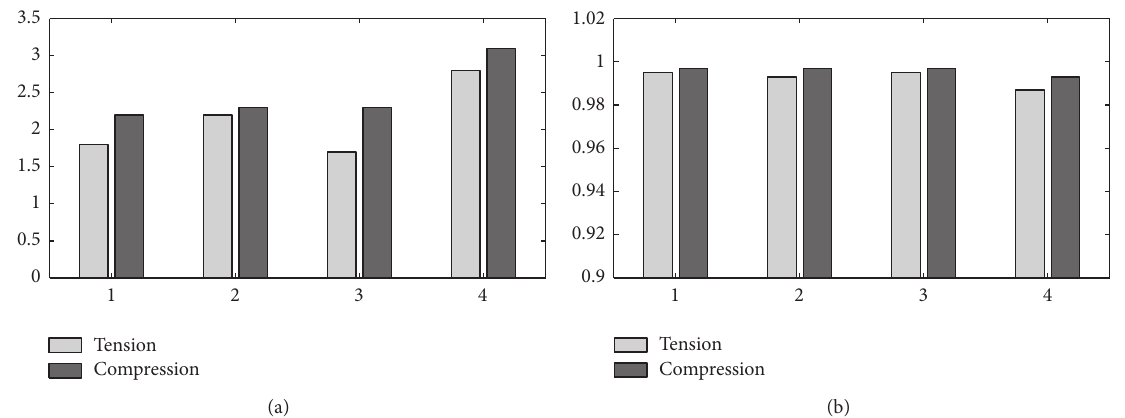
Figure 7: Comparison of the four equations: (a) error (%) and (b)